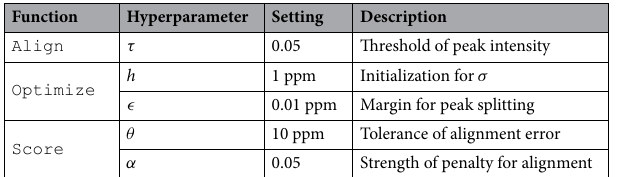
Table 2. Hyperparameter settings used for molecular search by